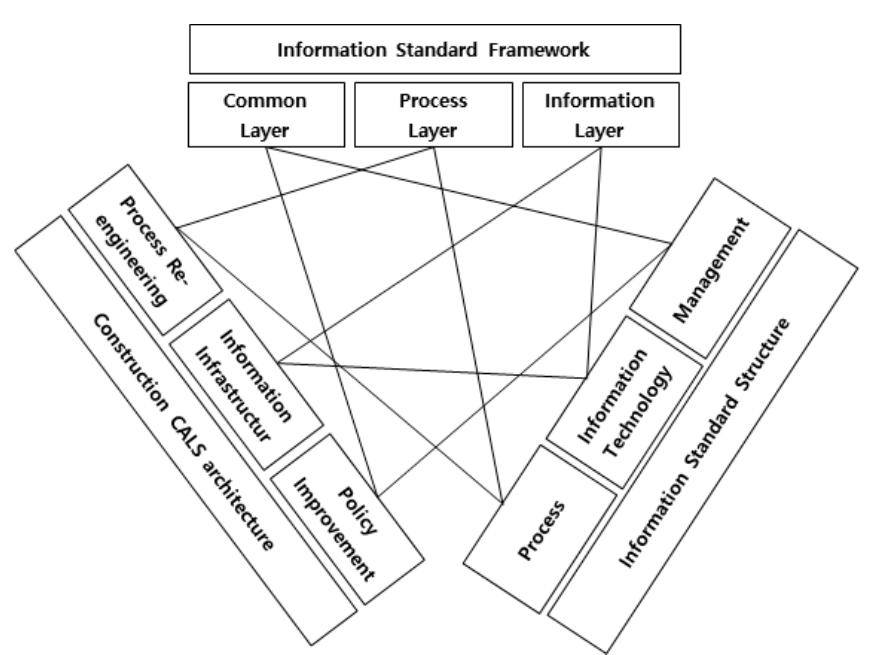
Figure 2. Composition of the information standard framework layer.